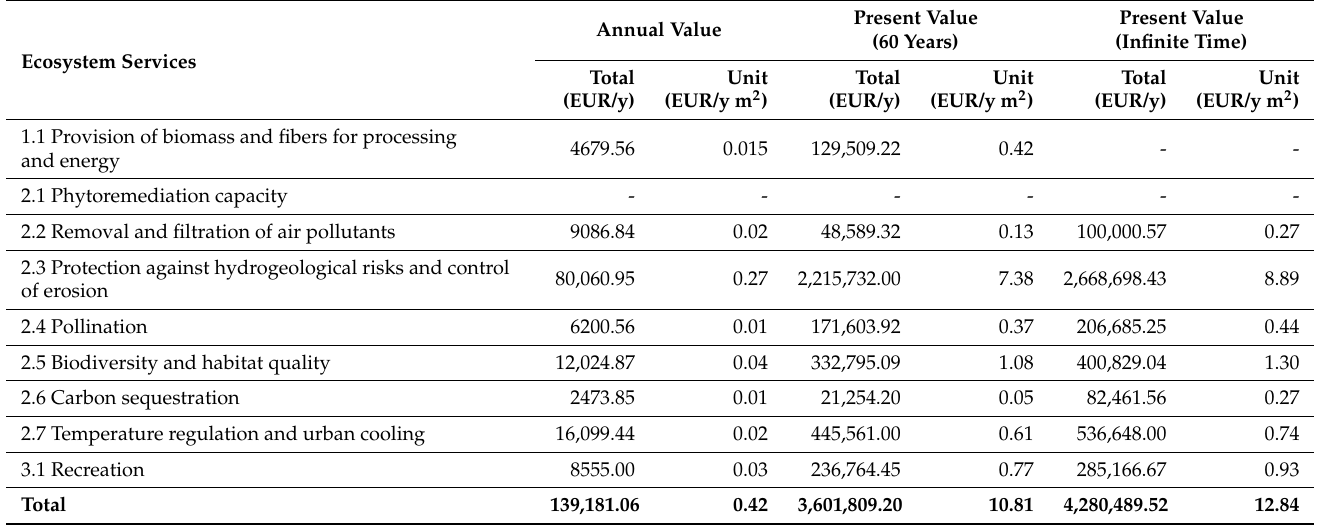
Table 12. Summary of ES values for scenario 1—urban forest.